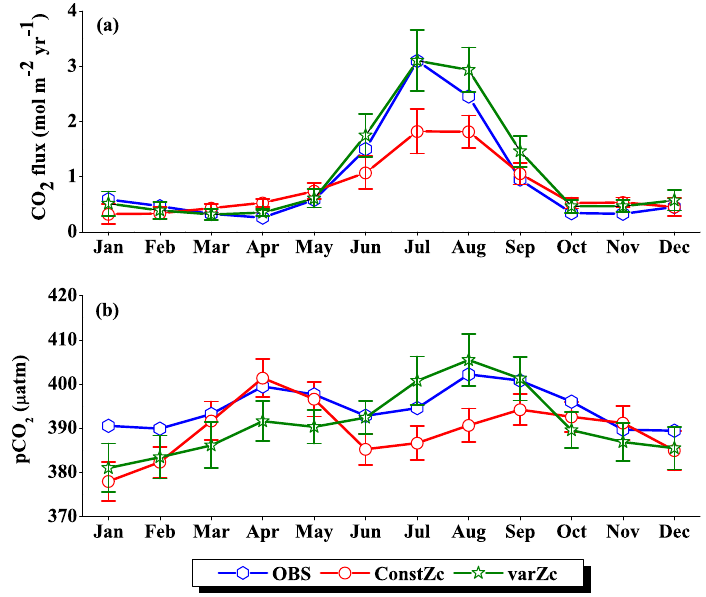
Figure 6. Comparison of model (a) CO 2 flux and (b) p CO 2 simulated with const Zc and var Zc with that of Takahashi et al. (2009) obser- vations (OBS) over WAS as climatology computed over 1990–2010. Error bar shows standard deviations of individual months over these